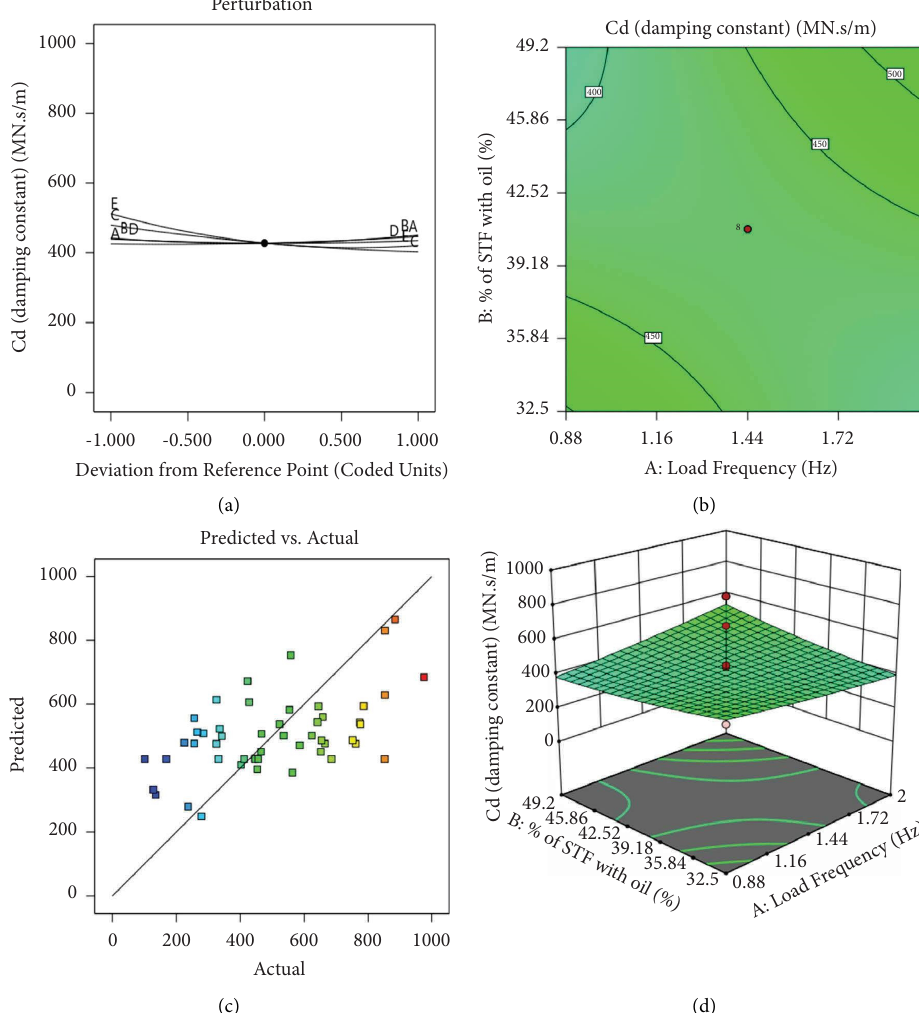
Figure 7: (a) Perturbation for damping constant. (b) Contour graph for damping constant. (c) Predicted vs. actual values for damping constant. (d) 3D graph for damping